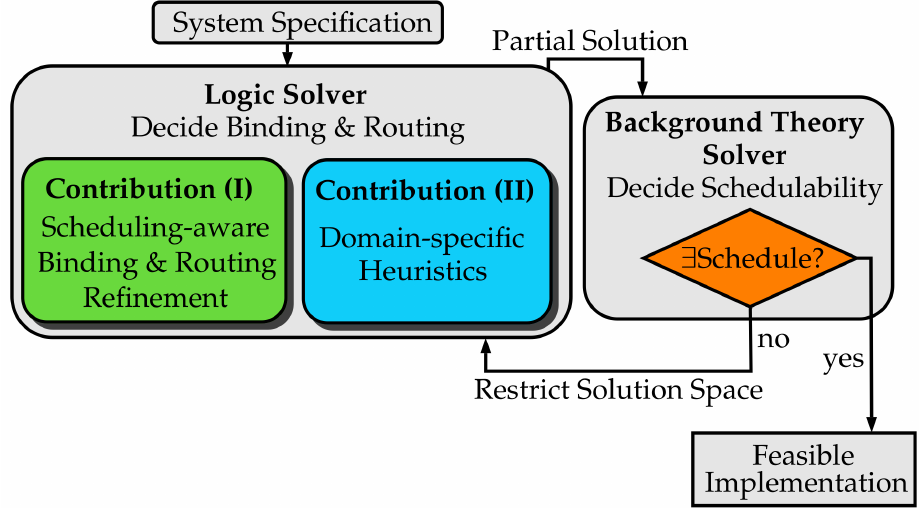
Figure 1. Overview of the contributions within the symbolic system synthesis approach presented in this